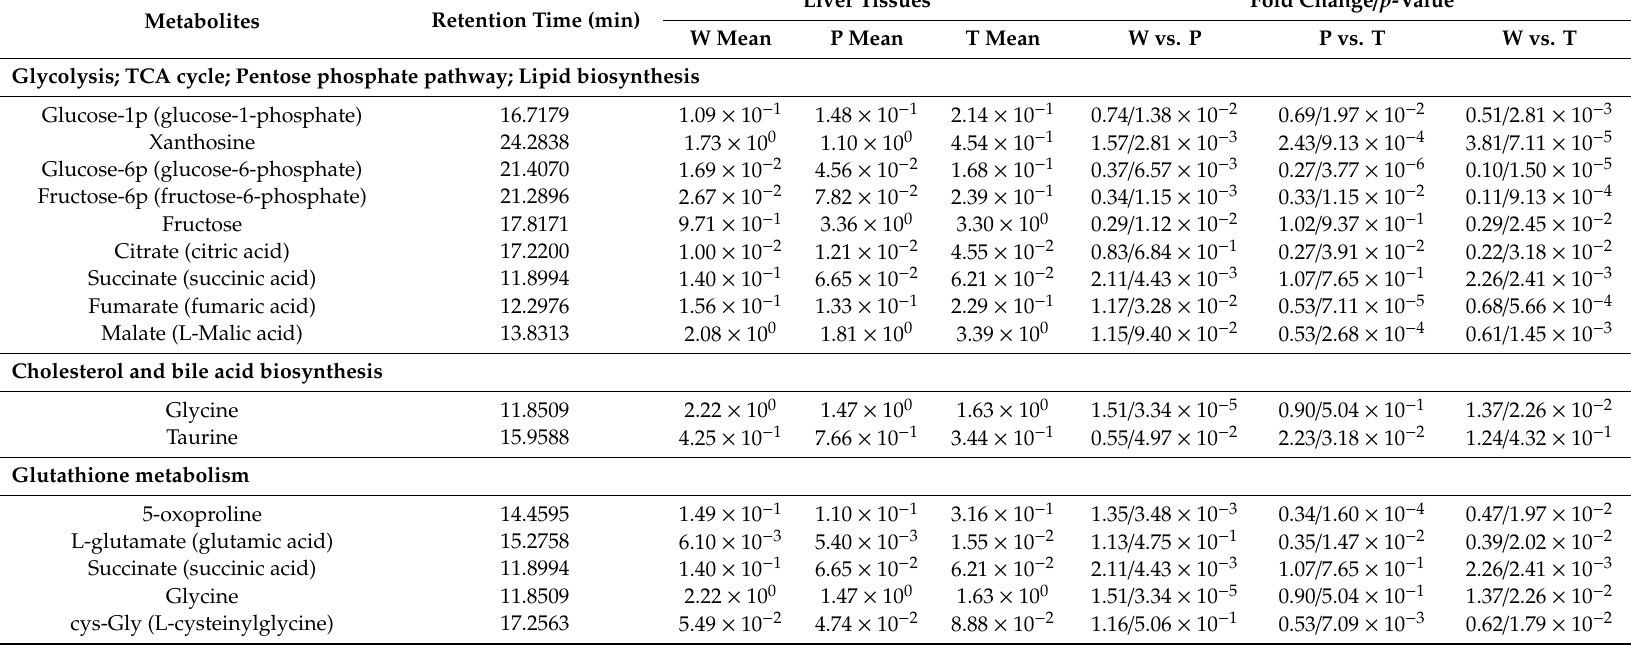
Table 1. DEMs in paired comparisons between W, P, and